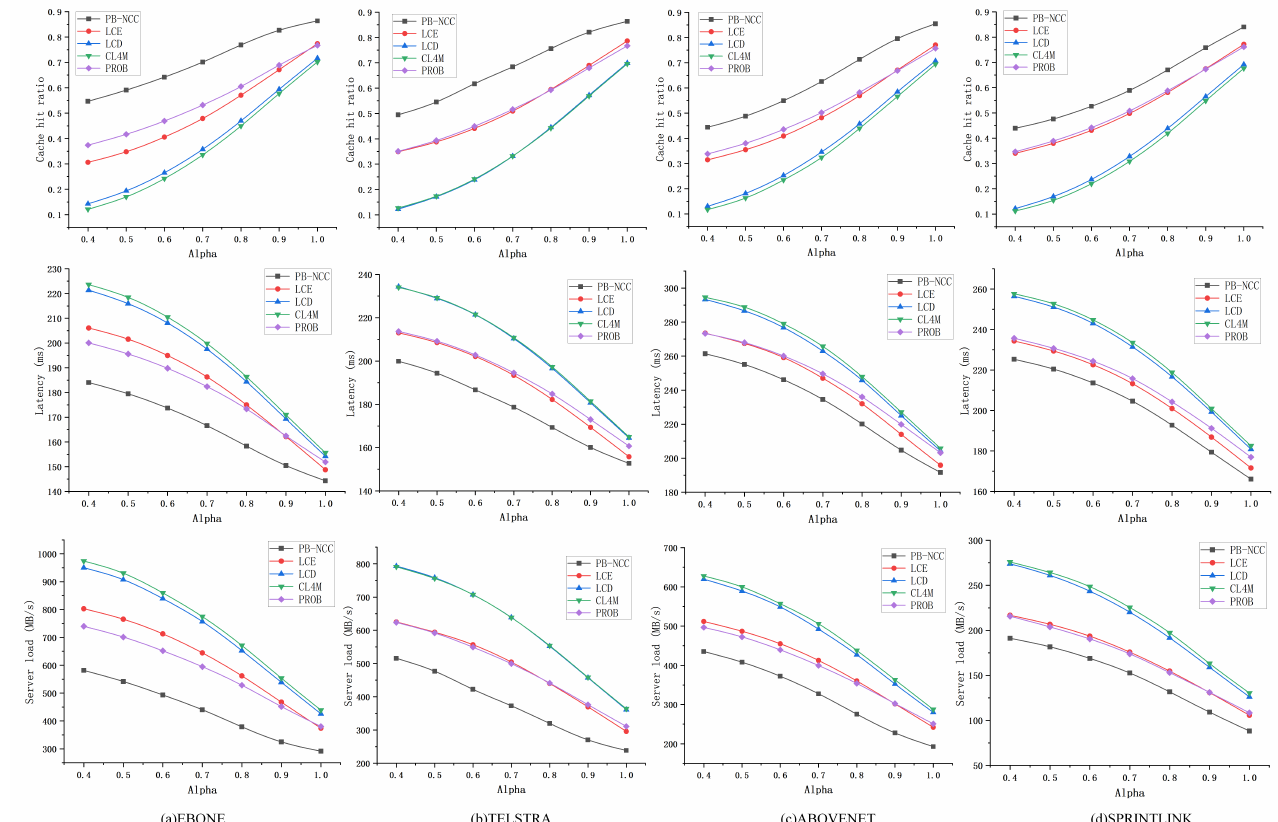
Figure 10. Comparison in ISP-like topologies when the Zipf parameter α changes. ( a ) performance in EBONE topology under a different Zipf parameter α ; ( b ) performance in TELSTRA topology under a different Zipf parameter α ; ( c ) performance in ABOVENET topology under a different Zipf parameter α ; ( d ) performance in SPRINTLINK topology under a different Zipf parameter α